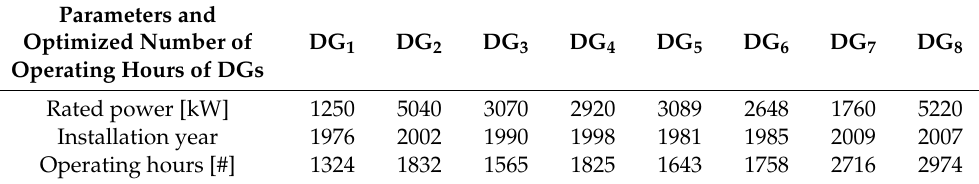
Table 2. Operating hours of diesel generators in the TO-BE scenario 1.